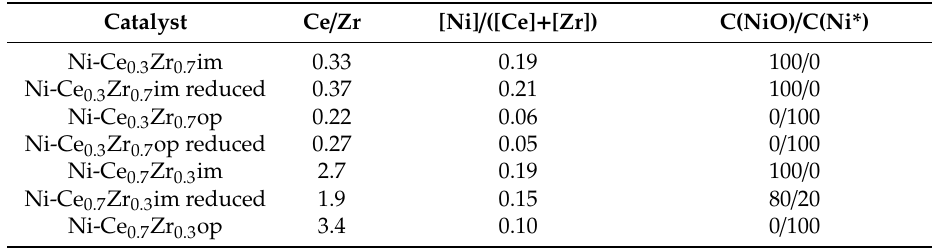
Table 3. Surface characteristics of NiCeZrO